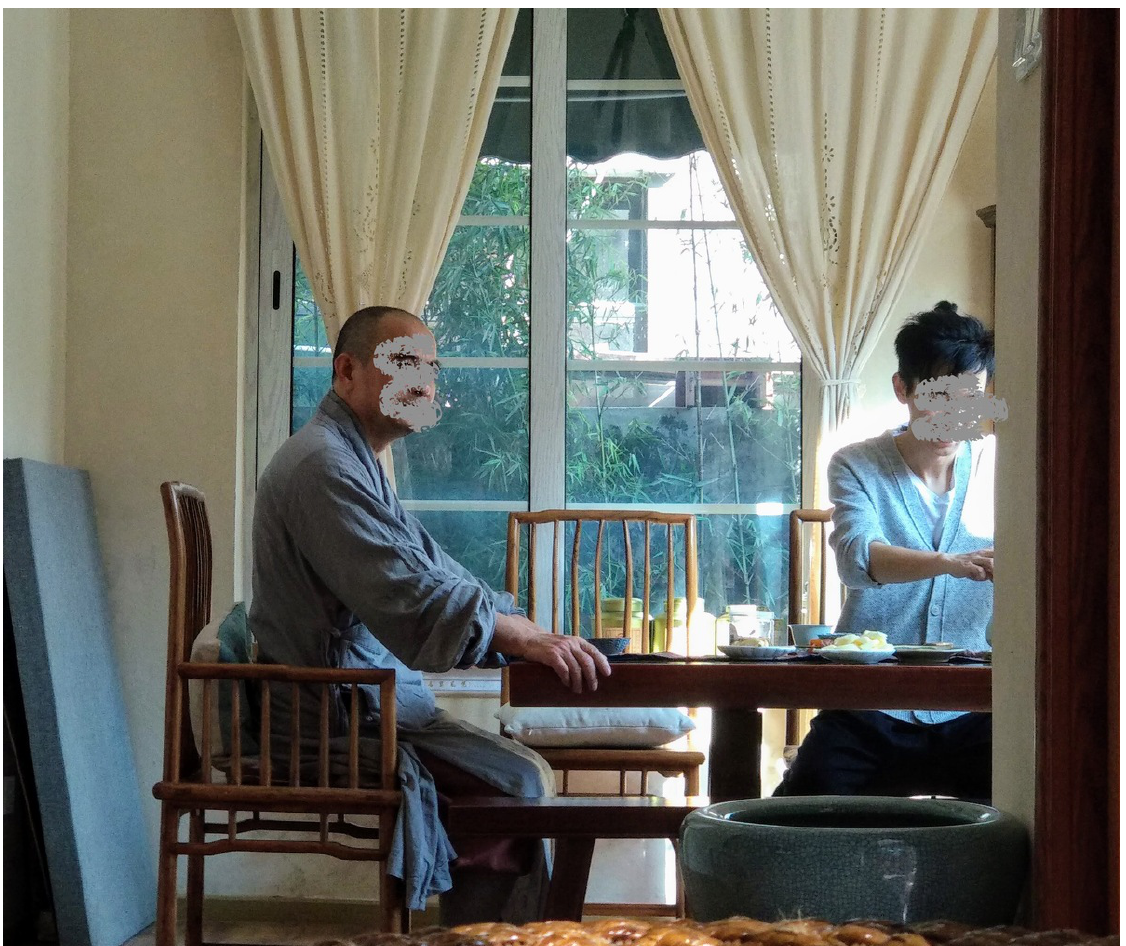
Figure 6 The Ru family tea